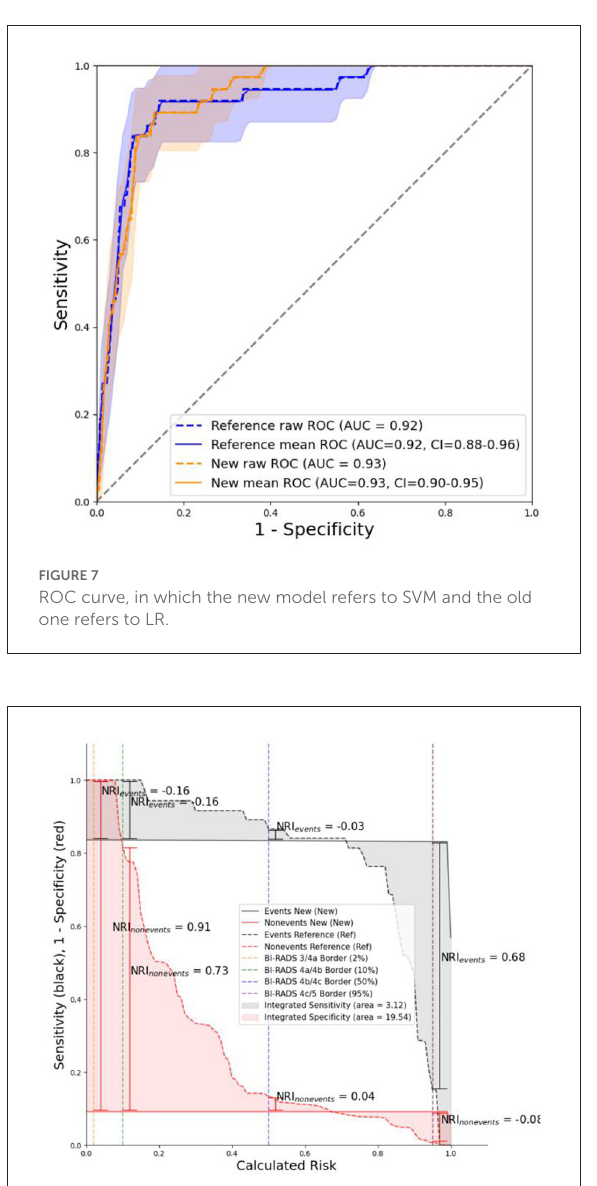
FIGURE8 IDI curve, in which the new model refers to SVM and the old one refers to